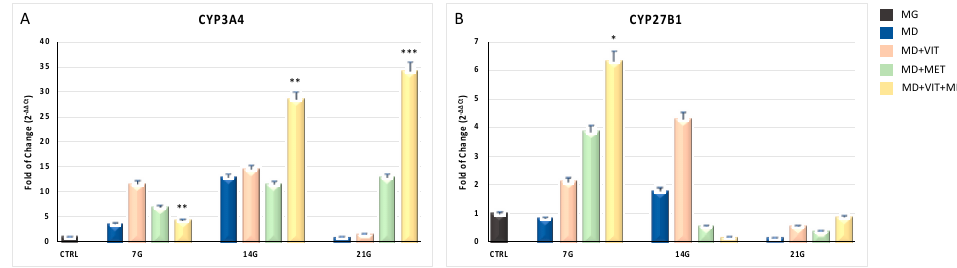
Figure 2. Expression of CYP450. The expression of CYP3A4 (Panel ( A )) and CYP27B1 (Panel ( B )) was evaluated in ADSCs cultured in: growing medium (MG), adipogenic differentiation medium (MD) (blue bars), or in MD in the presence of vitamin D (orange bars), or in MD in the presence of metformin (green bars), or in MD with metformin plus vitamin D (yellow bars). The mRNA levels for each gene were normalized to glyceraldehyde-3-phosphate-dehydrogenase (GAPDH) and expressed as fold of change (2 − ∆∆ Ct ) of the mRNA levels observed in undi ff erentiated control ADSCs (black bars) defined as 1 (mean ± SD; n = 6). Data are expressed as mean ± SD referred to the control (* p ≤ 0.05; ** p ≤ 0.01; *** p ≤ 0.001).